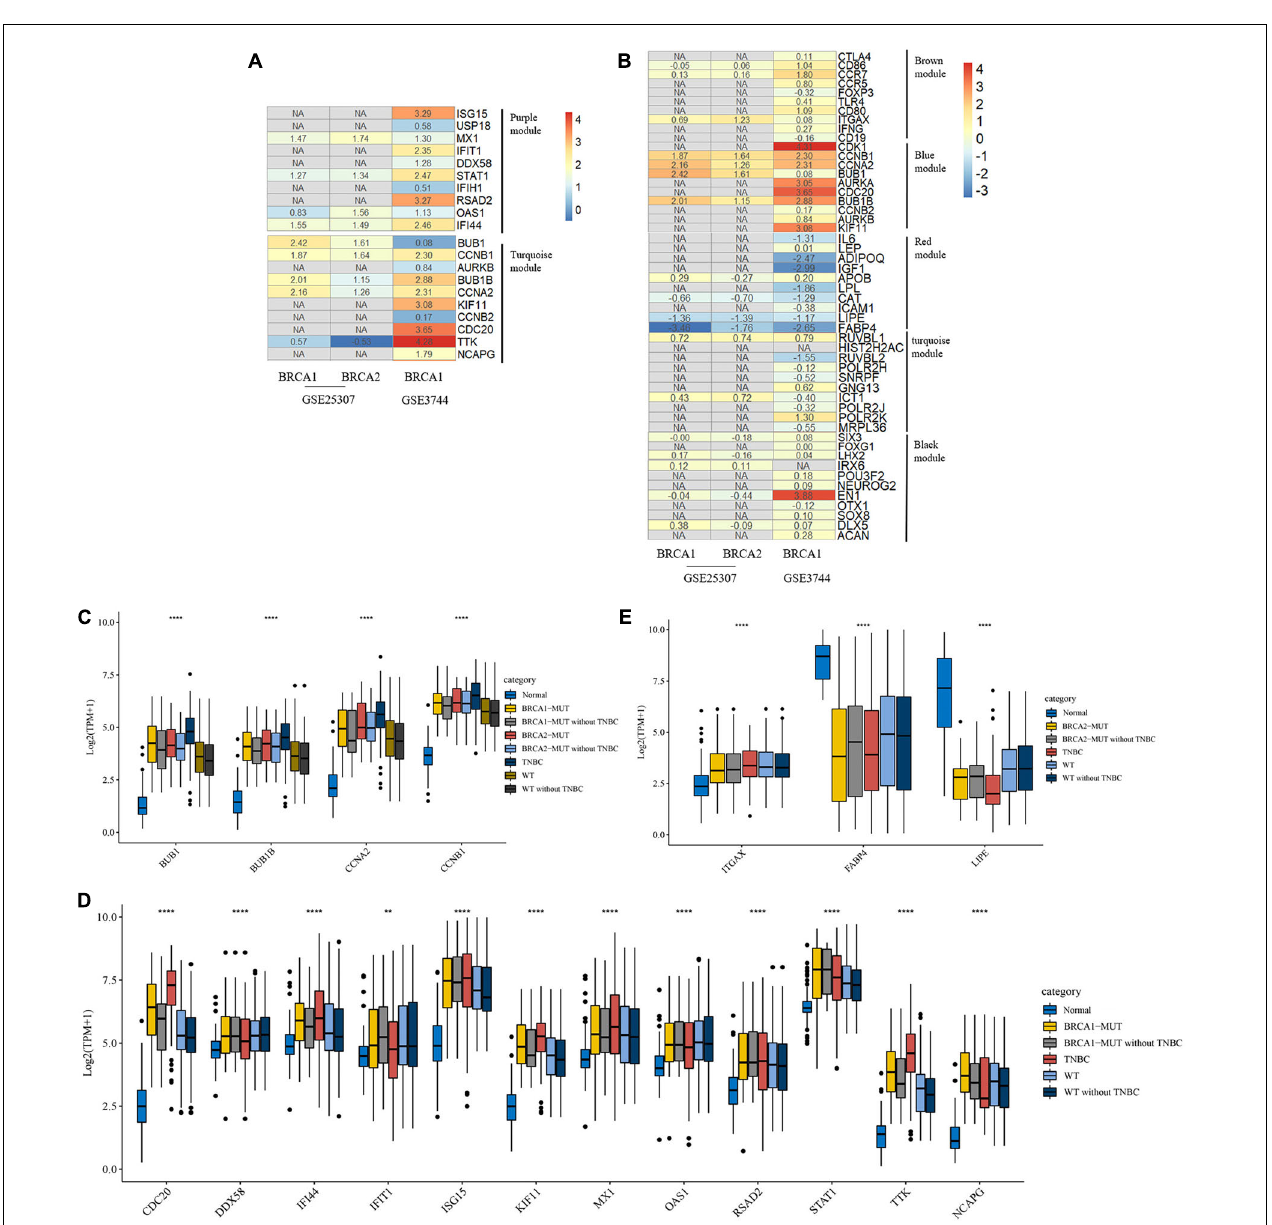
FIGURE 5 | Heatmap of log2FC values for external validation of hub genes using GEO datasets and transcriptional expression levels of validated hub genes. (A,B) Heatmaps of log2FC values for hub genes in BRCA1 -MUT (A) and BRCA2 -MUT (B) BC cohorts for GEO external validation. The ordinate is the gene name and the abscissa represents different groups in GEO datasets. Values are log2FC values of each gene in three sets, where FC is calculated as the mean gene expression in the relevant group divided by the corresponding gene expression in normal tissue. “NA” represents GEO datasets that did not contain these genes. (C–E) Expression levels of validated hub genes in BRCA1 -MUT (C,D) and BRCA2 -MUT (C,E) BC. To show the potential effects of TNBC subtypes on BC, the hub gene expression was analyzed in multiple groups: normal ( N = 112), BRCA1 -MUT BC ( N = 36), BRCA1 -MUT BC excluding TNBC ( N = 26), BRCA2 -MUT BC ( N = 49), BRCA2 -MUT BC excluding TNBC ( N = 42), TNBC ( N = 116), WT ( N = 117), and WT excluding TNBC ( N = 103). ** P < 0.01, **** P <